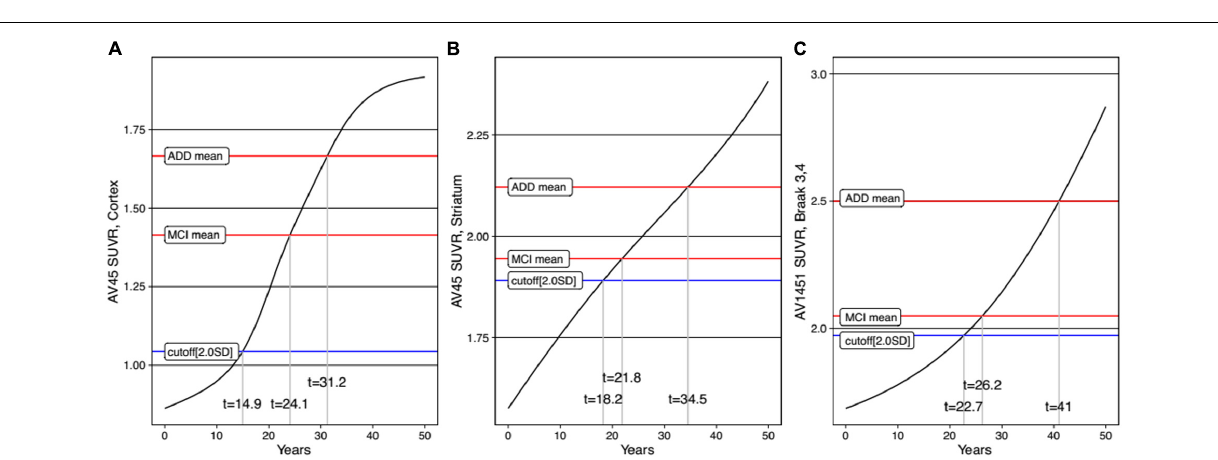
FIGURE 4 | Trajectories of AD biomarkers as a function of time in cortical amyloid (A) , striatal amyloid (B) , and pathological tau (C) . AV45, 18 F-florbetapir; SUVR, standardized uptake value ratio; AV1451, 18 F-flortaucipir.